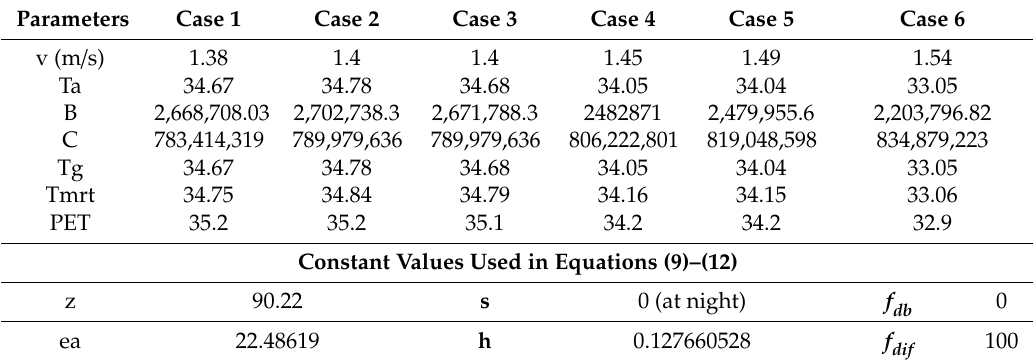
Table 9. Values used to calculate globe temperature (Tg), mean radiant temperature (Tmrt) and PET, in addition to the constant values used in Equations